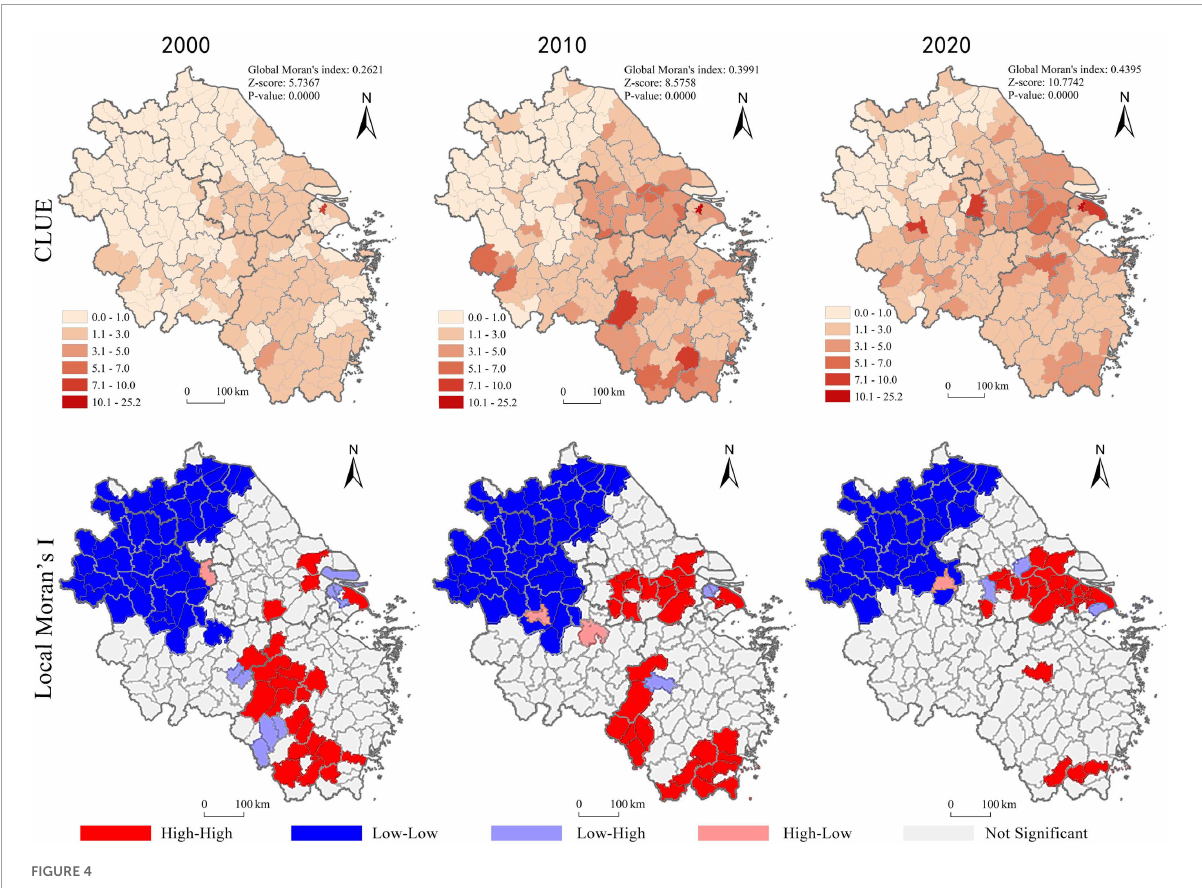
FIGURE4 The spatial patterns of CLUE (million RMB per hectare) in the YRD in 2000, 2010, and 2020.